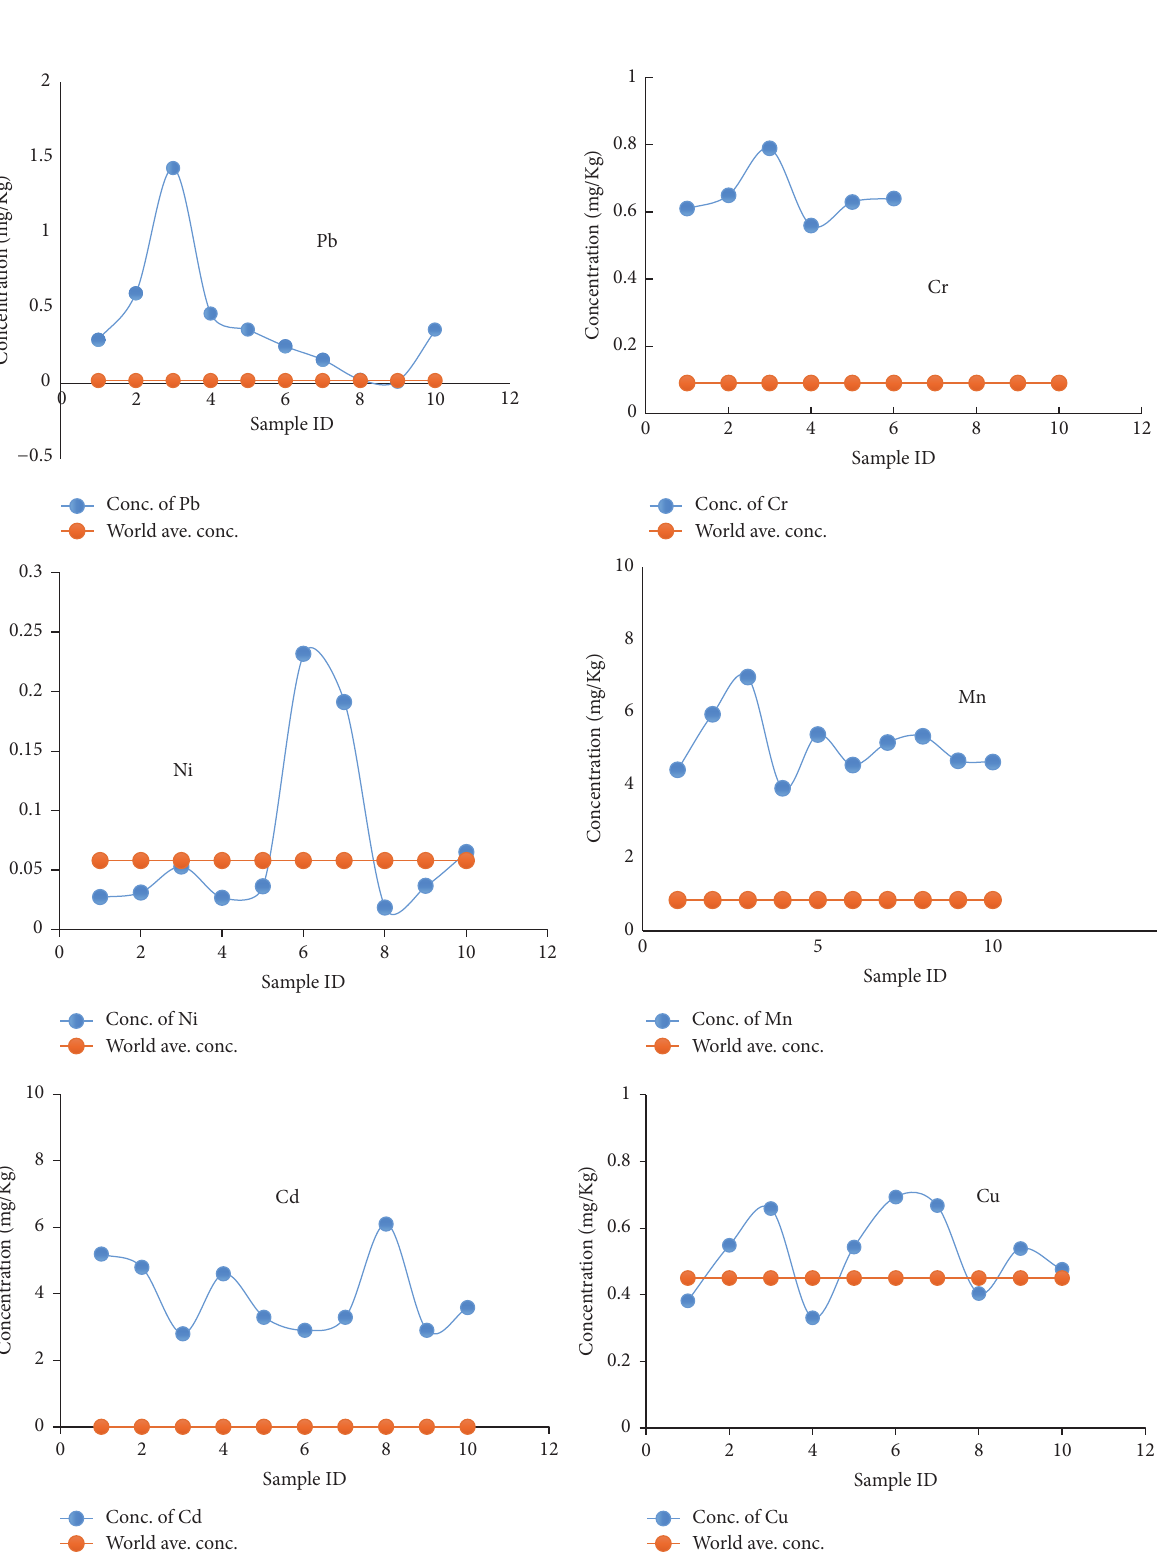
Figure 2: Concentration of minor elements measured versus world average concentration for different surface sediments